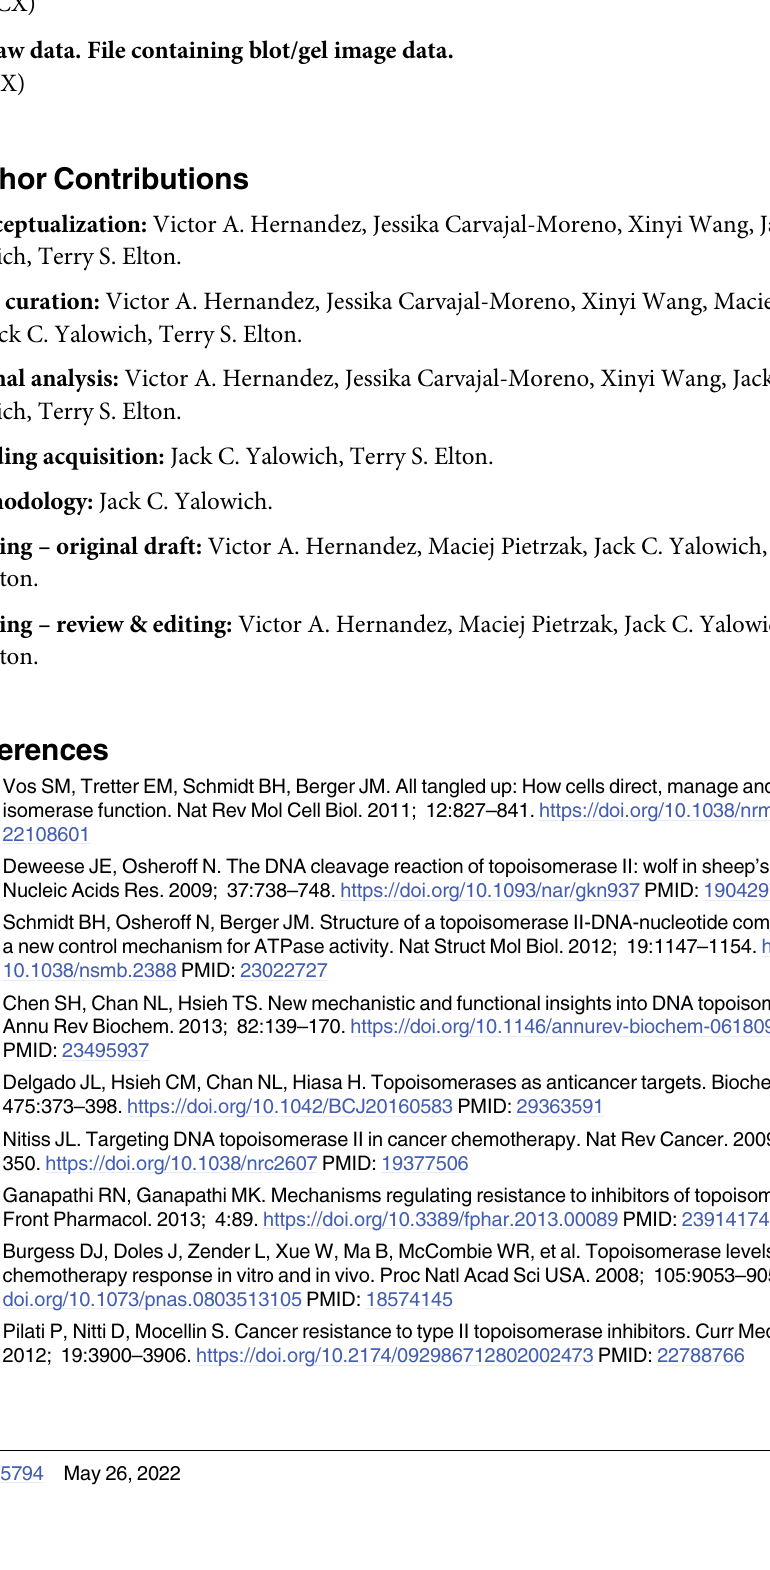
S1 Table. Sequences of primers, single strand oligonucleotides, and qPCR hybridization probes utilized in this study. S1 Raw data. File containing blot/gel image